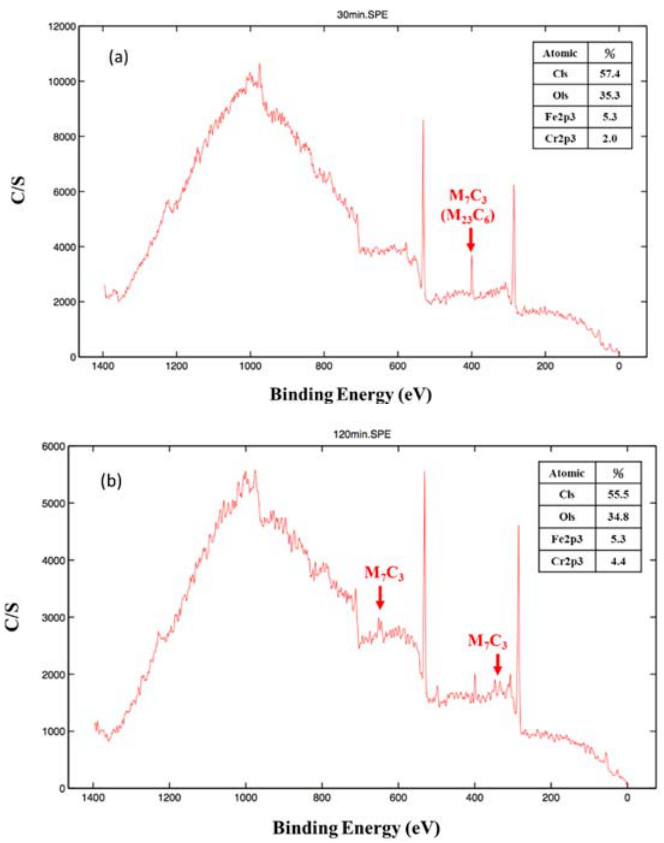
Figure 13. ESCA of carbides: ( a ) 30 min, and ( b ) 120min.